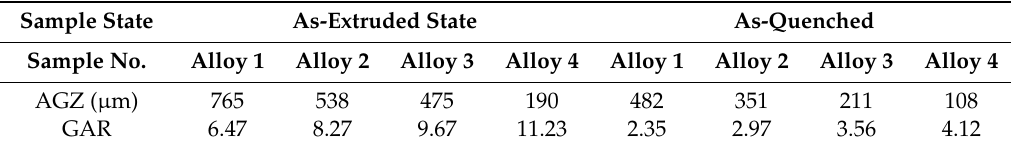
Table 2. Average grain size (AGZs) and grain aspect ratio (GARs) of four Al-Mg-Si-Cu alloys at different states.